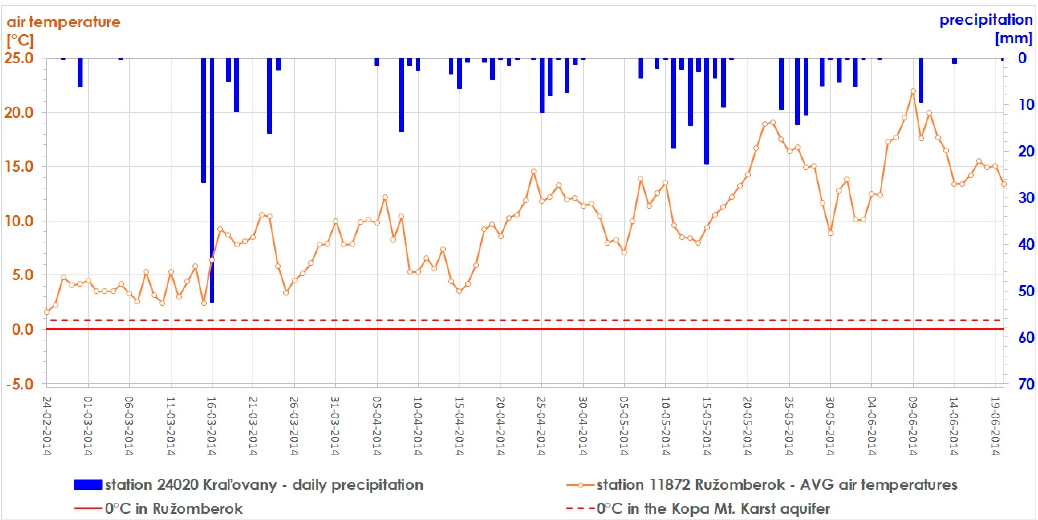
Figure 5. Daily air temperatures on Ružomberok station and daily precipitation totals at Kral’ovany station in the period between 24.02.2014 and 20.06.2014. Continuous red line is marking zero temperature at Ružomberok station, dashed red line signifies the temperature shift of the freezing point at the mean altitude of the Kopa Mt. karstic aquifer.